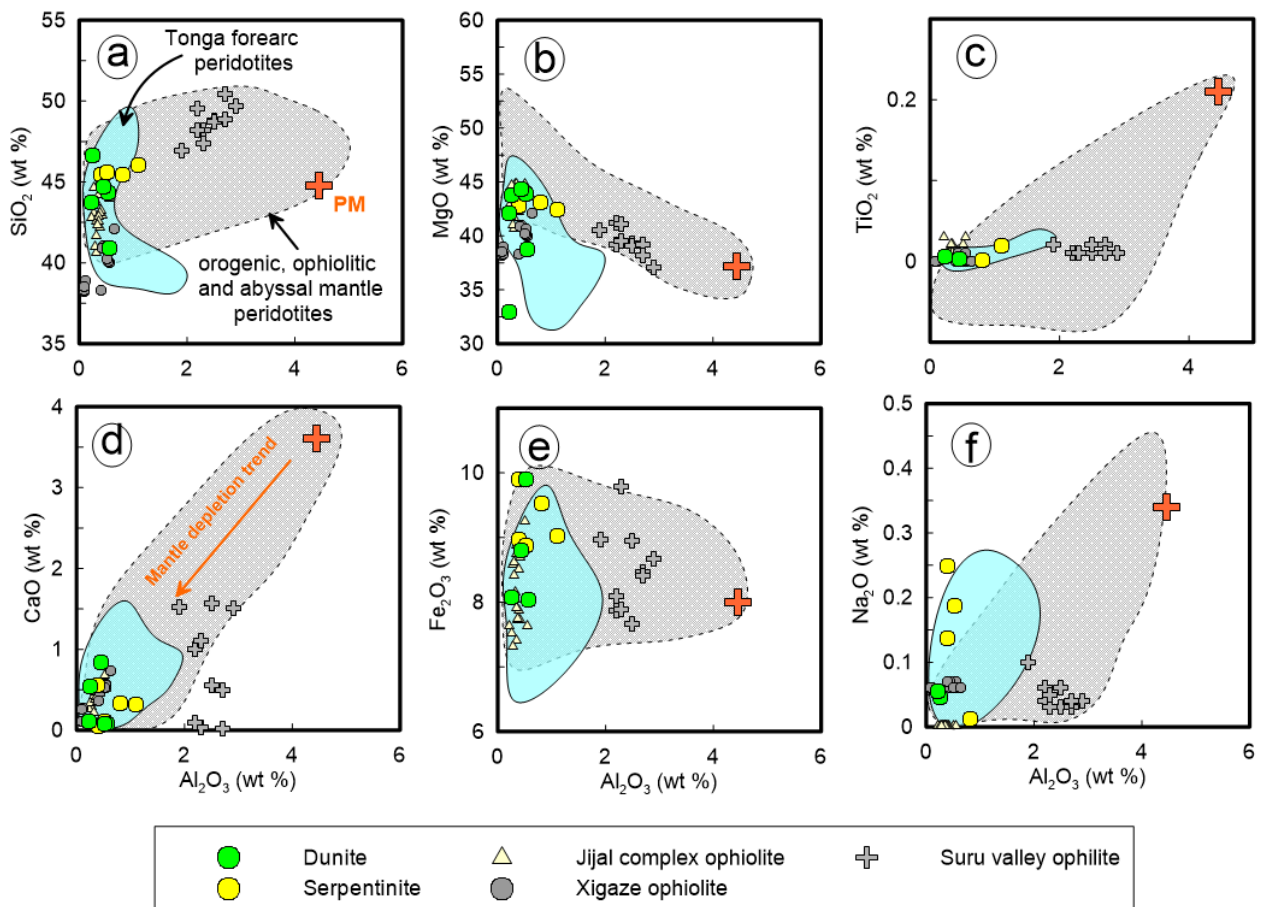
Figure 5. Variation diagrams of selected whole rock major element oxides against Al 2 O 3 (anhydrous wt. %) for the studied peridotites of WOC. The grey fields reflect the orogenic, ophiolitic, and abyssal mantle peridotites of Bodinier and Godard [51]. The sky blue fields represent Tonga forearc peridotites of Birner et al. [47] The supra-subduction zone peridotites of Ullah et al. [24], Bhat et al. [52], and Xiong et al. [46] are plotted for comparison. Primitive mantle (PM) values are from Sun and McDonough [45] and McDonough et al.